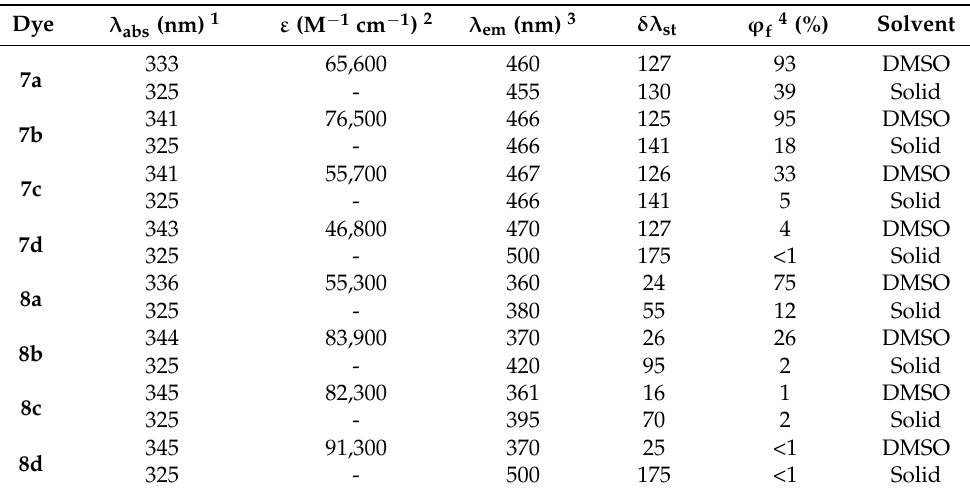
1 Absorption maximum. 2 Molar absorption coefficients. 3 Fluorescence maximum. 4 In solution: determined by comparison with fluorescein ( ϕ f = 0.90 in water with NaOH 0.1 mol L − 1 ) [39] at room temperature; in the solid state: measured using an integrating sphere, the excitation wavelength was 375